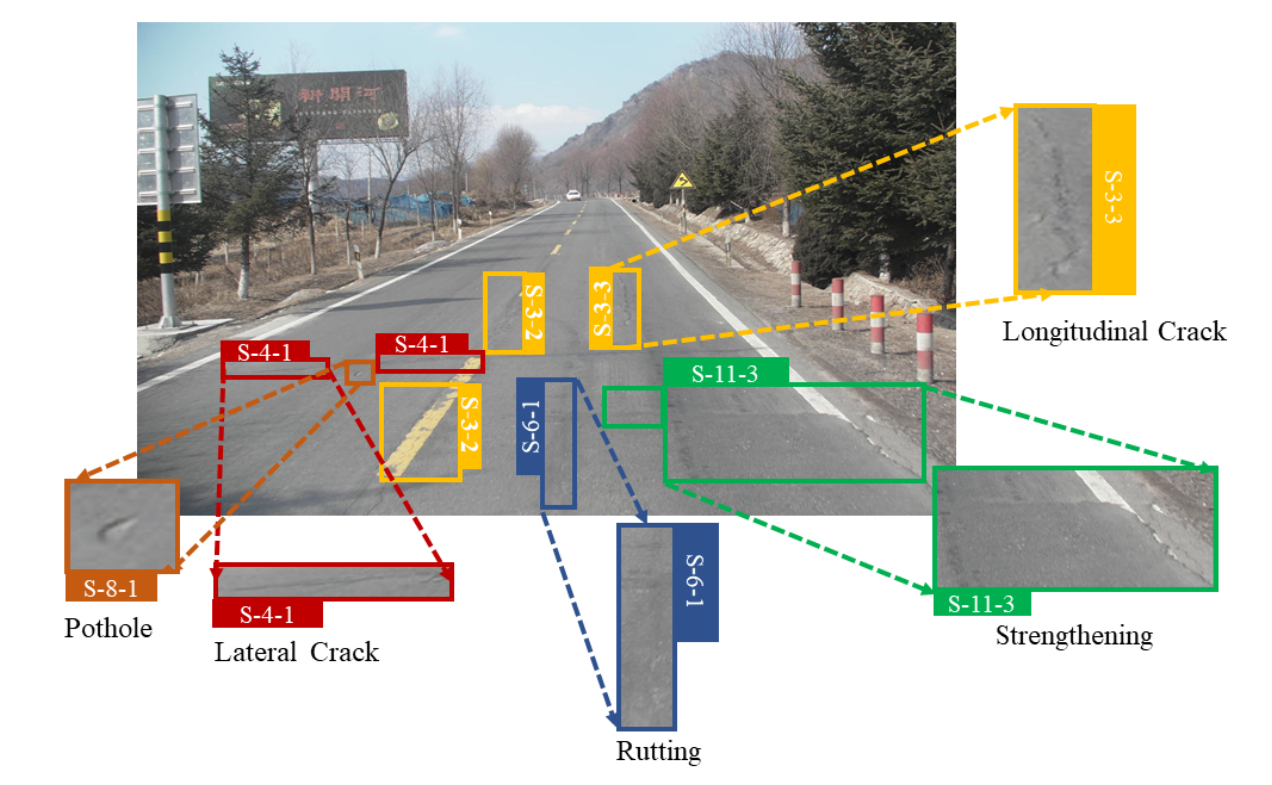
Figure 1. An example image from CNRDD. Various colored bounding boxes represent different types of road